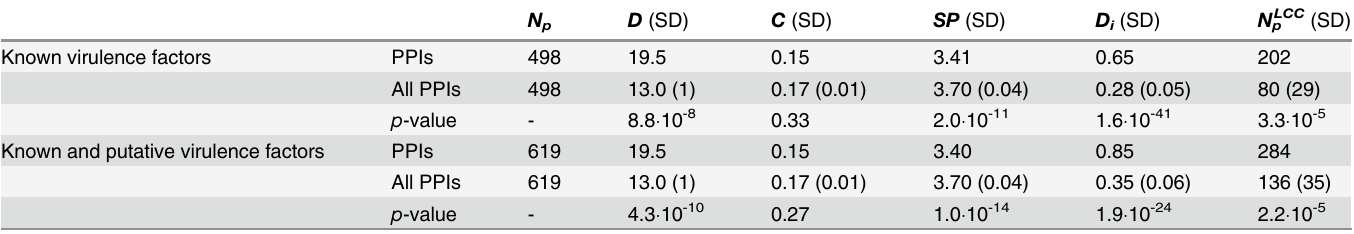
Table 3. Topological properties of human proteins interacting with B. mallei . We evaluated the following properties of the host proteins that interacted with B. mallei proteins based on the human protein-protein interaction (PPI) network [25]: the number of these host proteins in the human PPI network ( N p ); the average number of interacting partners (in the human PPI network) of each host protein ( D ); the clustering coef fi cient, i.e., the number of interactions among the nearest neighbors ( C ); the average shortest path between any two proteins in the set ( SP ); the average number of interacting partners in the human PPI network where both partners interact with B. mallei proteins ( D i ); and the number of host proteins in the largest connected ). The top three rows show the results for the host proteins present in the PPI that interacted with the nine known virulence factors, component ( N LCC p whereas the three lower rows correspond to host proteins that interacted with all 21 tested B. mallei proteins from the yeast two-hybrid screening (known and putative virulence factors). The results for the randomly selected (498 or 619) human proteins from the entire human PPI network (All PPIs) were generated through 10 3 random repetitions to create averages and standard deviations. The indicated p -values correspond to the probability of the observed properties being different from the randomly selected set from all